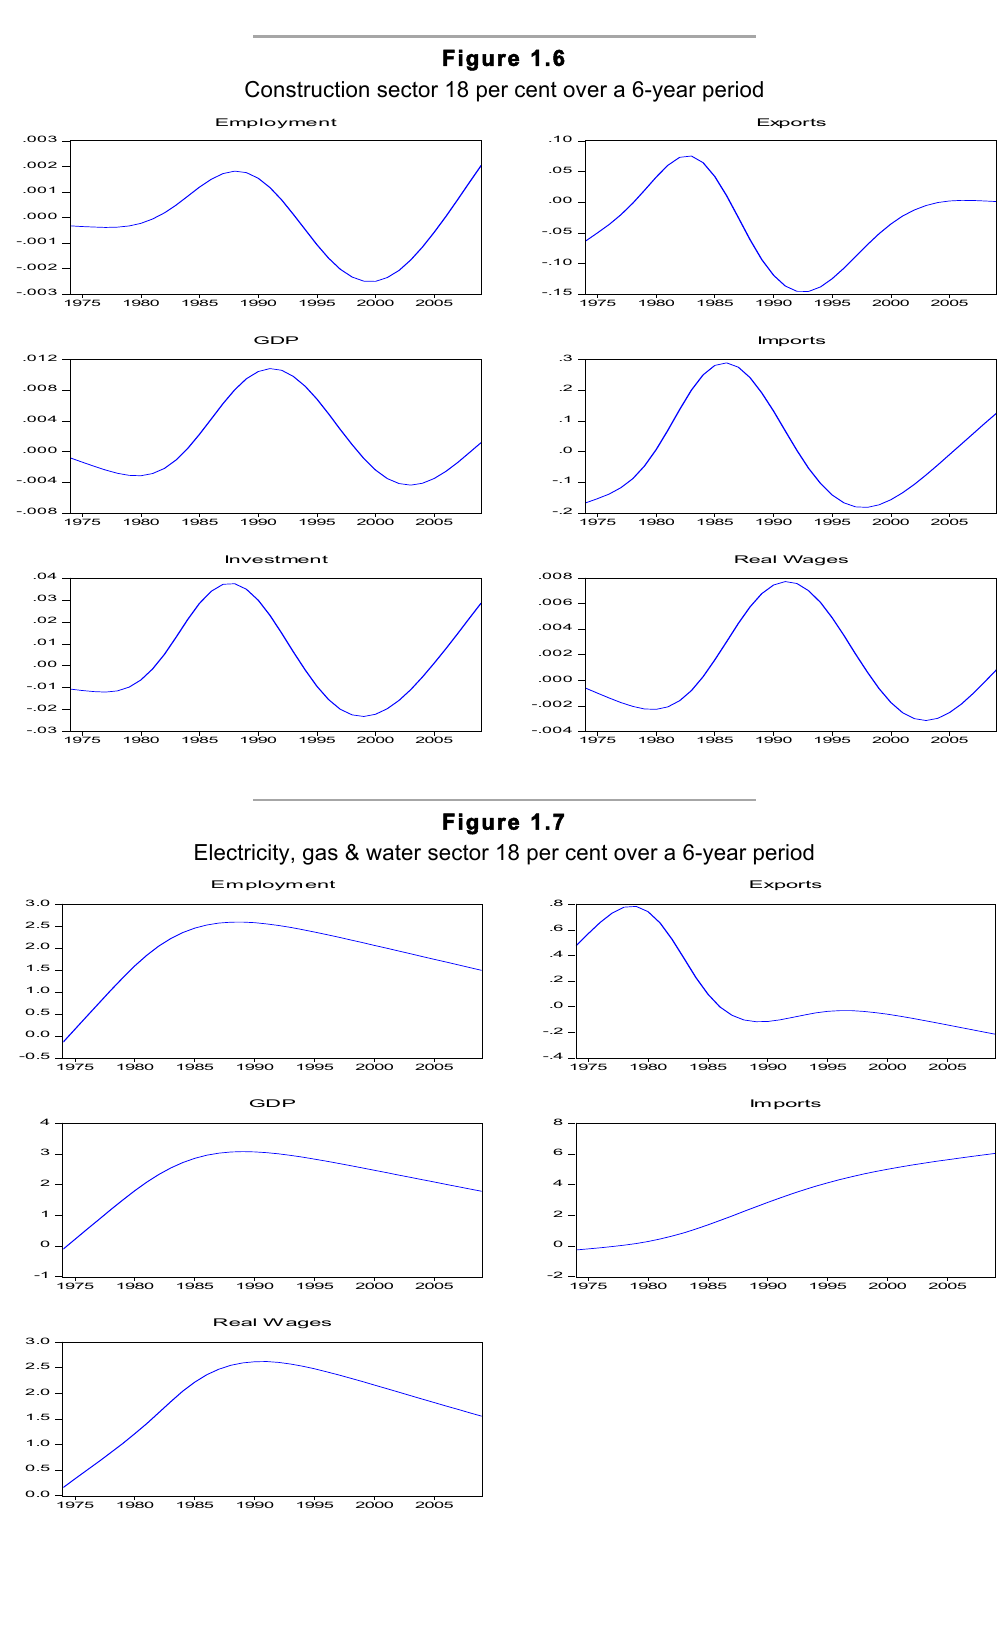
Construction sector 18 per cent over a 6-year